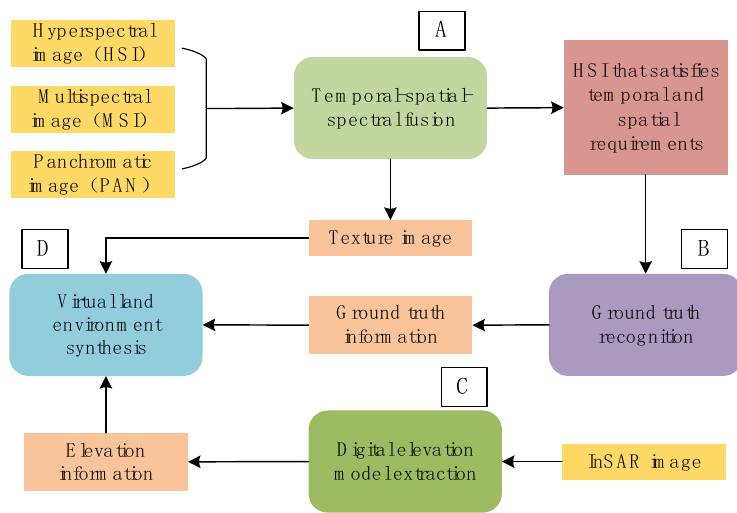
Figure 1. The process of constructing a virtual land environment using multi-source satellite Earth observation data.